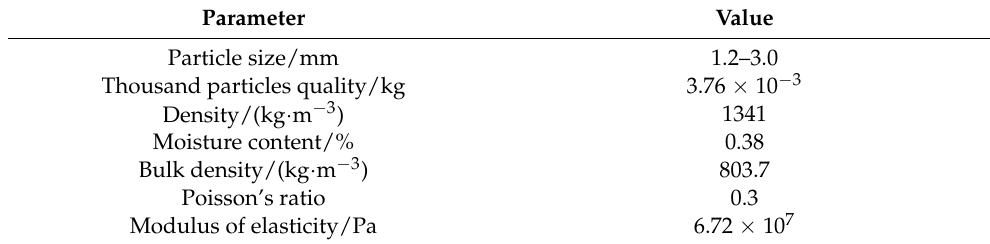
Table 1. Basic physical characteristic parameters of urea particles.